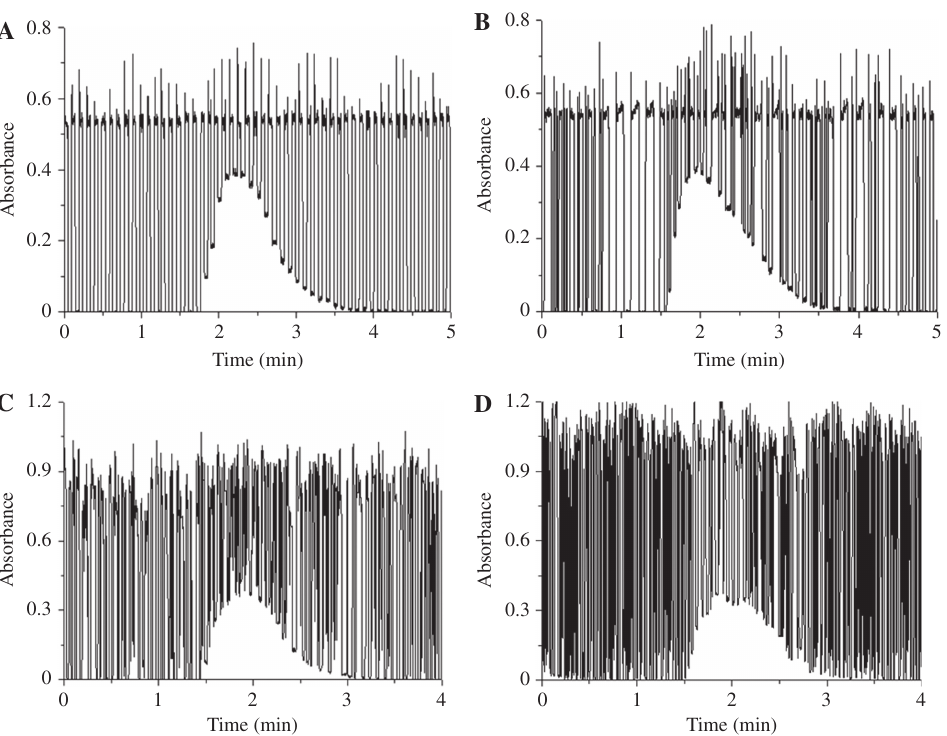
= F = 5 μ l/min; F = 0; Θ ( × 10 3 ) = 0) and for varying dimen- w O D D ( × 10 3 ) = 4, and (D) Θ ( × 10 3 ) = 10. D D